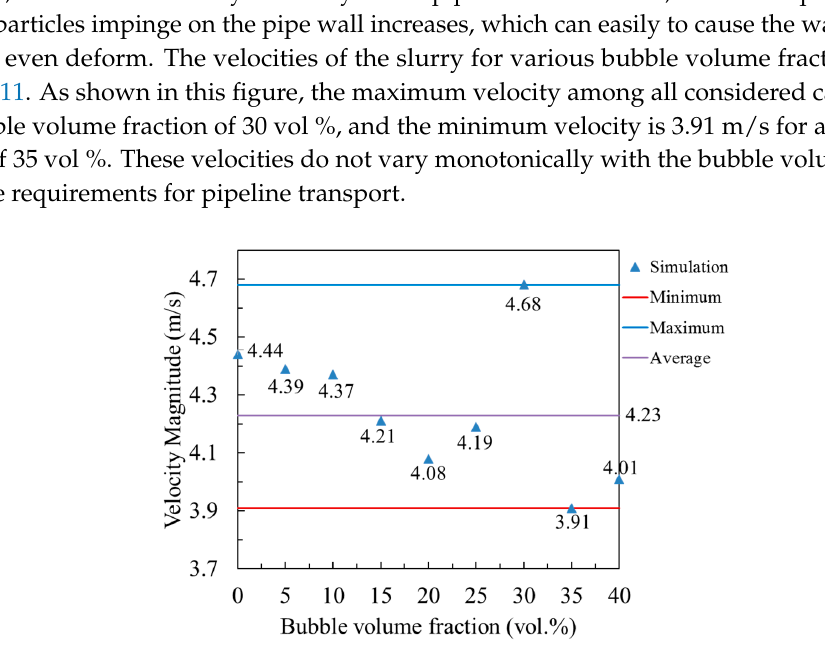
Table 5. Comparison between the pressures in the pipeline and the elbow.